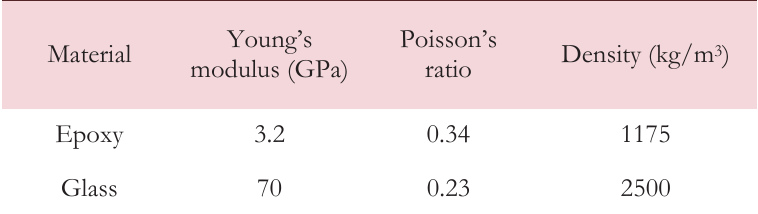
Table 2: The properties of the epoxy and glass [27]